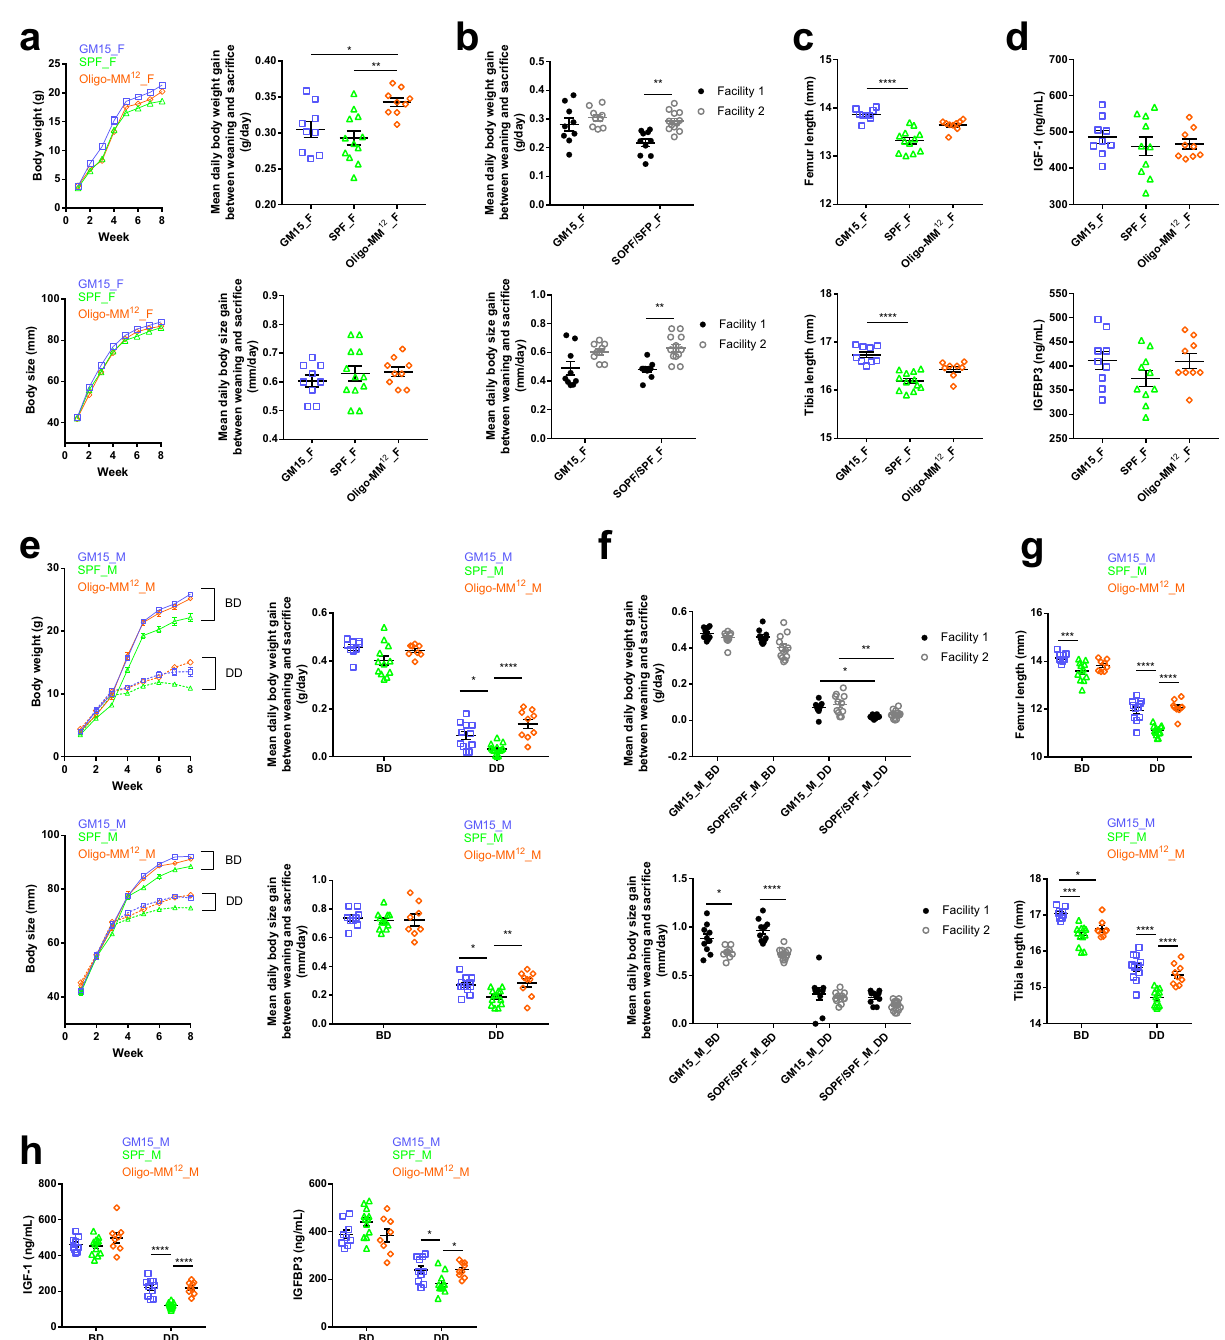
Fig. 8 The GM15 model growth and diet-induced stunting phenotypes are reproducible in another gnotobiotic facility. a – h Macroscopic phenotype of mice where dots, lines, and error bars represent, respectively, individual mice, means, and SEM. Female (F) and male (M), breeding diet (BD), and depleted diet (DD), respectively. a , e Body weight or size curves and mean daily gain of animals in facility 2. One-way ANOVA followed by Tukey ’ s multiple comparison analyses (GM15 mice: 9 F, 9 M_BD, 11 M_DD; SPF mice: 12 F, 12 M_BD, 13 M_DD; Oligo-MM 12 mice: 9 F, 8 M_BD, 9 M_DD). b , f Mean daily body weight and size gain comparison between GM15 and SOPF/SPF mice in facilities 1 (GM15 mice: 9 F, 10 M_BD, 9 M_DD; SOPF mice: 10 F, 10 M_BD, 10 M_DD) and 2 (GM15 mice: 9 F, 9 M_BD, 11 M_DD; SPF mice: 12 F, 12 M_BD, 13 M_DD). One-way ANOVA followed by Tukey ’ s multiple comparison analyses. c , g One-way ANOVA analyses of femur and tibia length of animals in facility 2. One-way ANOVA followed by Dunn ’ s and Tukey ’ s multiple comparison analyses for F and M data sets, respectively (GM15 mice: 9 F, 9 M_BD, 11 M_DD; SPF mice: 12 F, 12 M_BD, 13 M_DD; Oligo-MM 12 mice: 9 F for femur and 8 F for tibia, 8 M_BD, 9 M_DD). d , h Serum IGF-1 and IGFB3 of animals at day 56 in facility 2. One-way ANOVA followed by Tukey ’ s multiple comparison analyses (GM15 mice: 9 F, 9 M_BD, 10 M_DD; SPF mice: 10 F, 12 M_BD, 12 M_DD; Oligo-MM 12 mice: 9 F, 8 M_BD, 9 M_DD). * P < 0.05, ** P < 0.01, *** P < 0.001, **** P < 0.0001. Source data are provided as a Source Data fi le.